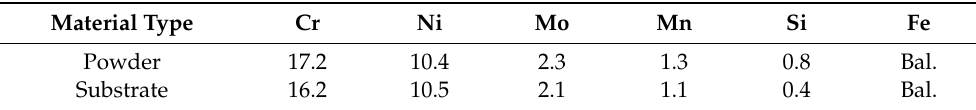
Figure 2. ( a ) SEM micrograph of the 316L powder feedstock with spherical particles of 53–150 µm diameter used in the production of honeycomb structures, ( b ) Schematic illustration of the blown powder DED process. Table 1. Chemical composition of the powder feedstock and substrate used in the experiment (wt.%)